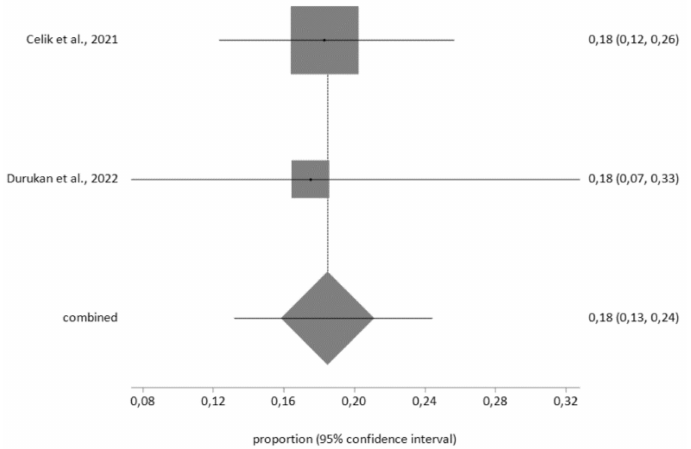
Figure 5. Prevalence of depression in hypertensive patients using the Hospital Anxiety and Depres- sion Scale